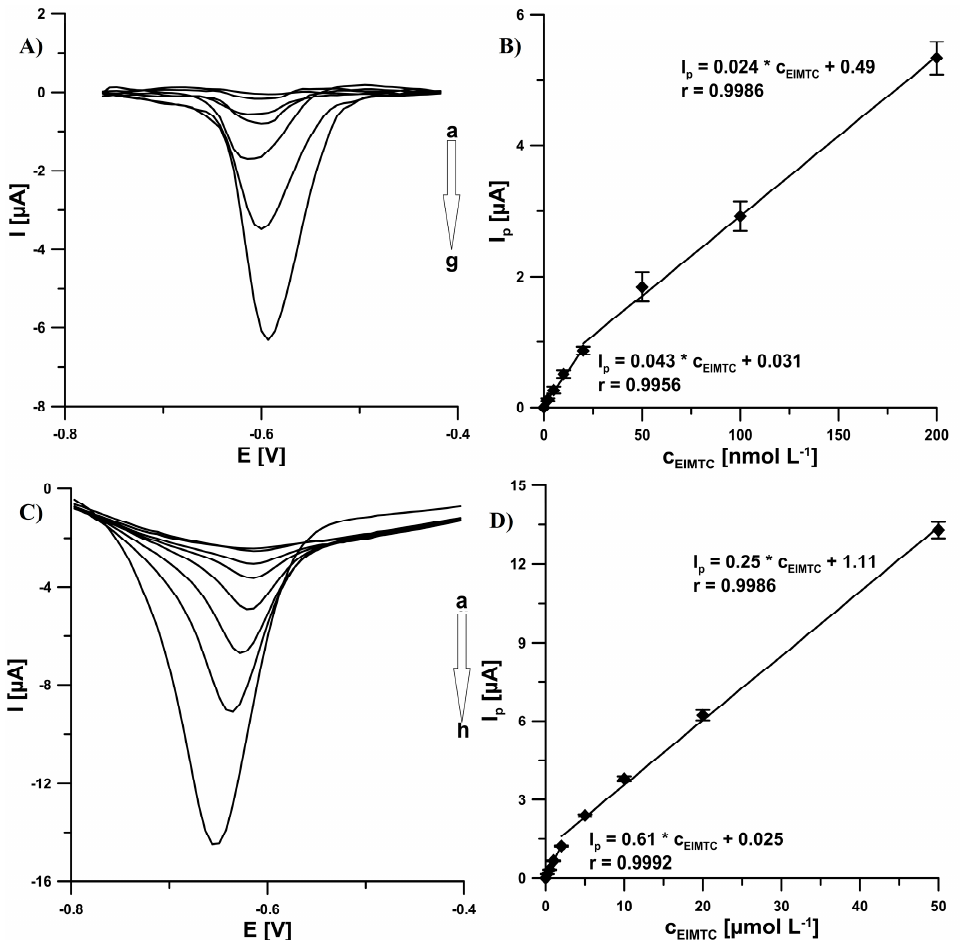
5.0 × 10 − 8 (e), 1.0 × 10 − 7 (f), 2.0 × 10 − 7 (g) mol L − 1 . B) Linear ranges of the calibration graph of EIMTC in